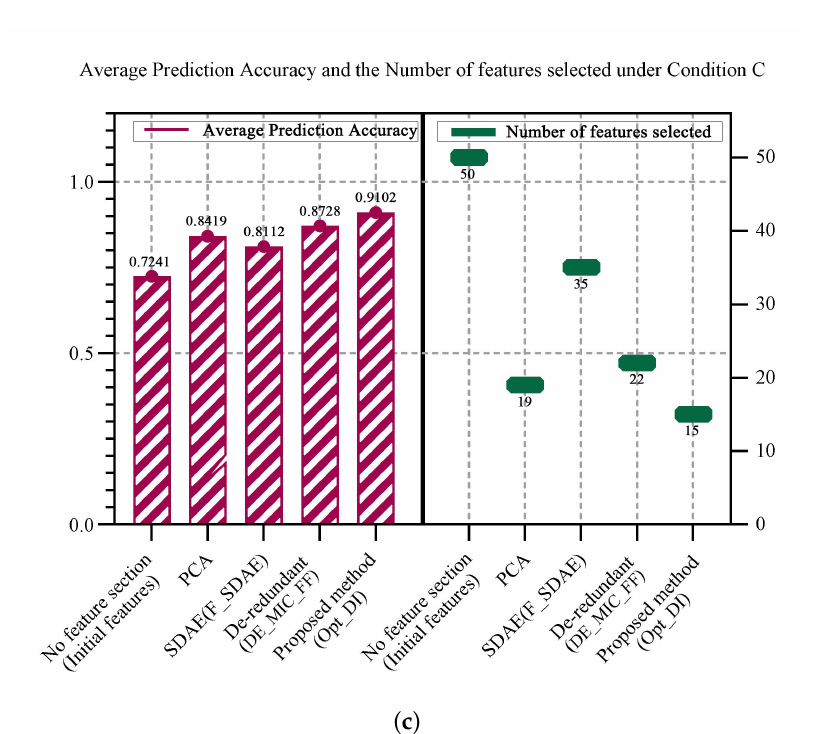
Figure 12. Average prediction accuracy and number of features selected under three operating conditions. ( a ) average prediction accuracy and the number of features selected under condition A, ( b ) average prediction accuracy and the number of features selected under condition B, ( c ) average prediction accuracy and the number of features selected under condition C.